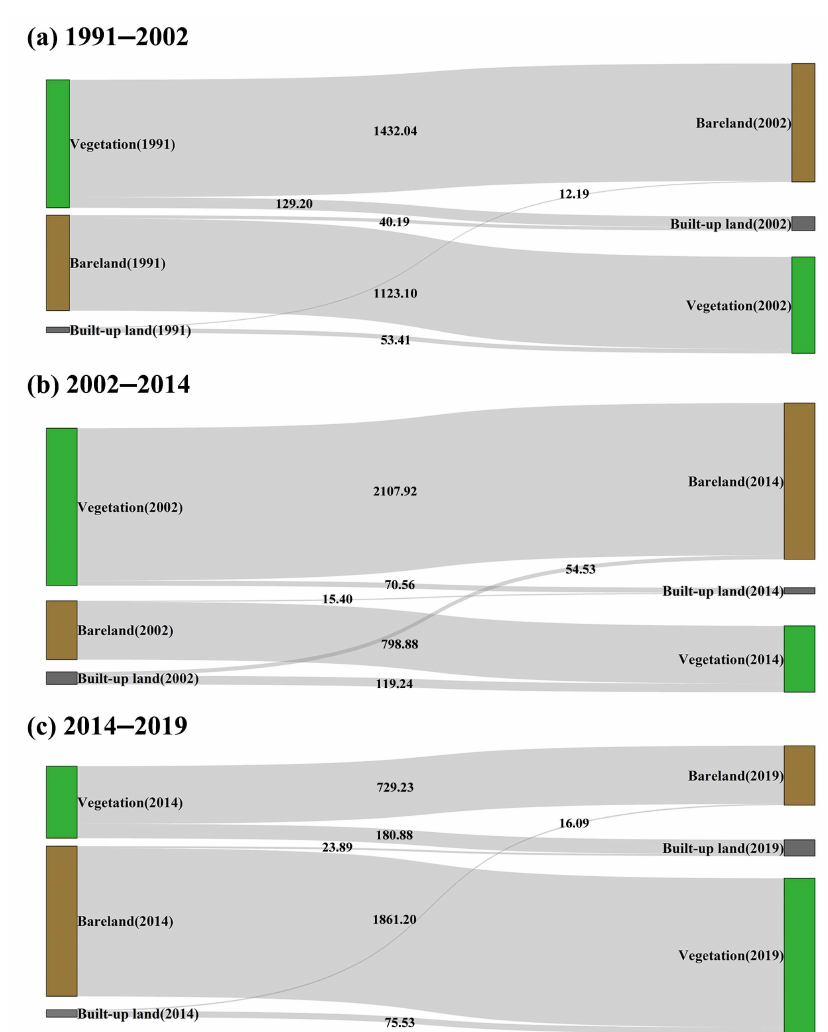
Figure 4. Schematic diagram of the transfer direction and area of land-use types. ( a ) 1991–2002; ( b ) 2002–2014 ( c ); 2014–2019 (The rectangle in the Figure represents the land-use type, where green represents vegetation, brown represents bare land, and dark gray represents the city; the size of the rectangle represents the total area of the transfer; the light gray curve represents the direction of feature transfer, and the thickness and number of curves represent the corresponding transfer direction and